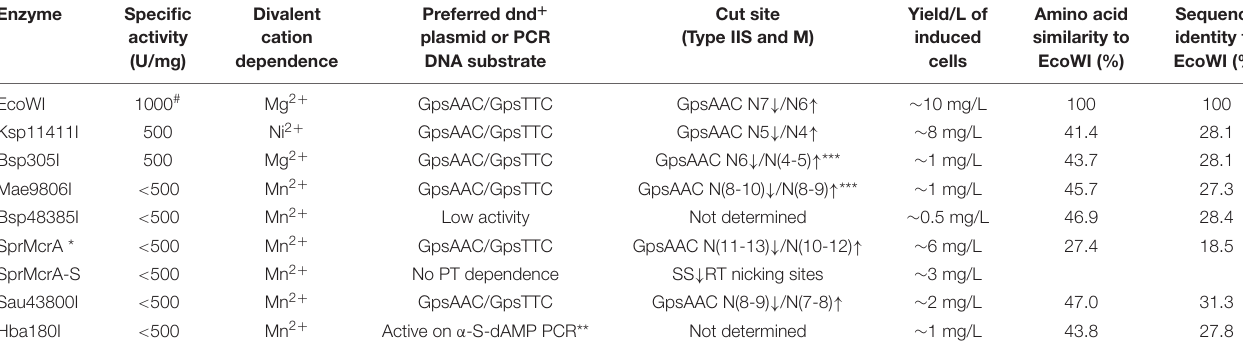
TABLE 1 | Summary of enzymatic properties of SBD-HNH endonucleases expressed, purified and characterized in this work. Enzyme Specific Divalent Preferred dnd + Cut